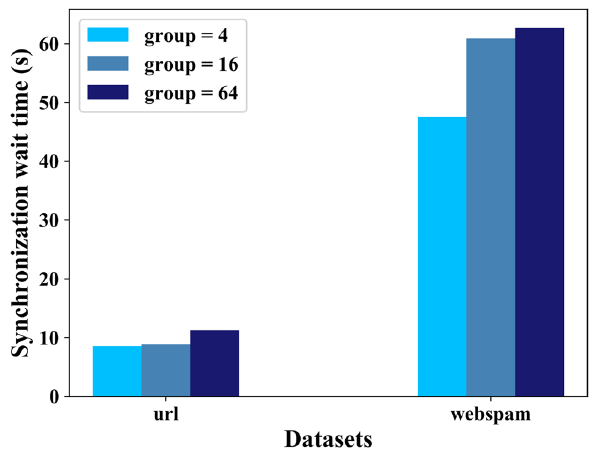
Fig. 7 Synchronization wait time of different # groups on the 2D-TGA-ADMM